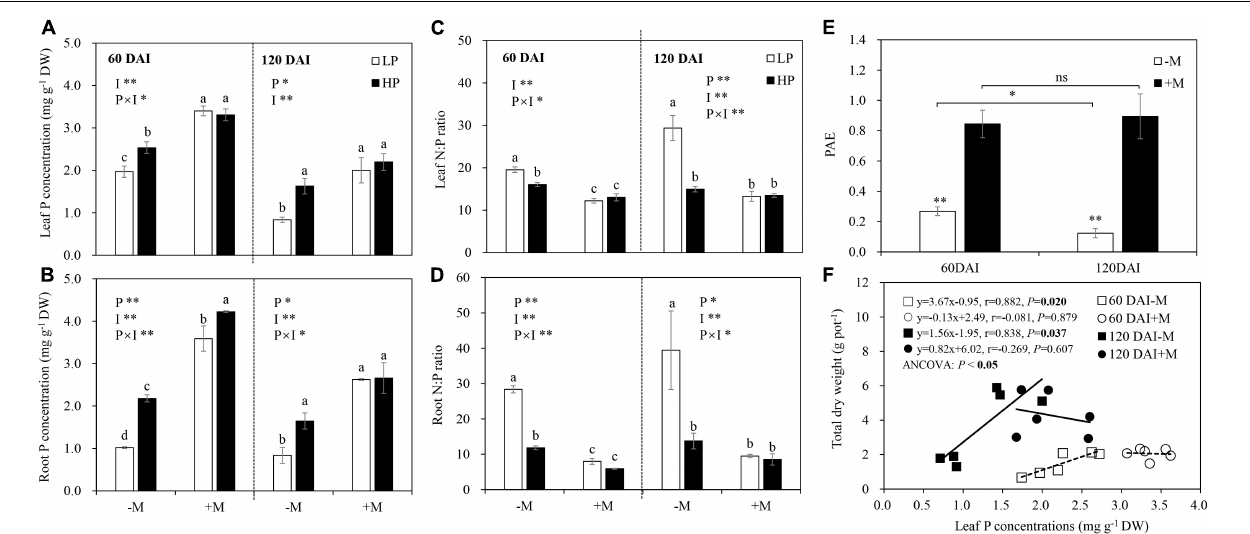
FIGURE 3 | (A) Leaf P concentration, (B) root P concentration, (C) leaf N:P ratio, (D) root N:P ratio, and (E) phosphate acquisition efficiency (PAE) as affected by soil P levels (P) and mycorrhizal status (I) 60 and 120 days after inoculation (DAI). DW represents dry weight. –M and +M represent non-AM and AM inoculation with R. irregularis , respectively. LP and HP represent 30 and 170 mg kg − 1 P application, respectively. Data are presented as mean ± standard error (SE, n = 3). Treatment effects were tested by two-way ANOVA separately between the two harvests. ∗ P < 0.05; ∗∗ P < 0.01. Multi-comparison was performed across all treatments at the same harvest time, and the same letter indicates no significant difference between the means at P < 0.05 by Turkey’s HSD test. (F) Leaf P concentration in relation to total dry weight for –M and +M plants at two harvests separately. Pearson correlation analyses were conducted to check the